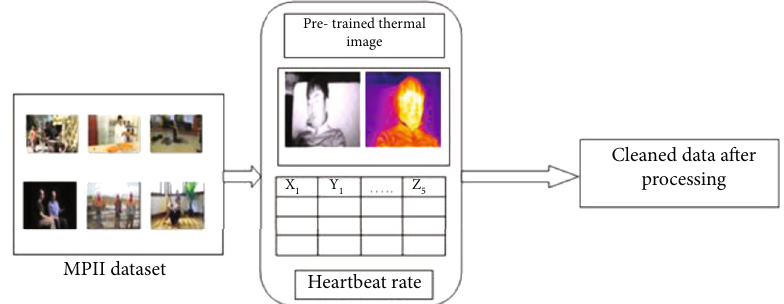
Figure 5: Data synthesis of the sleep dataset.